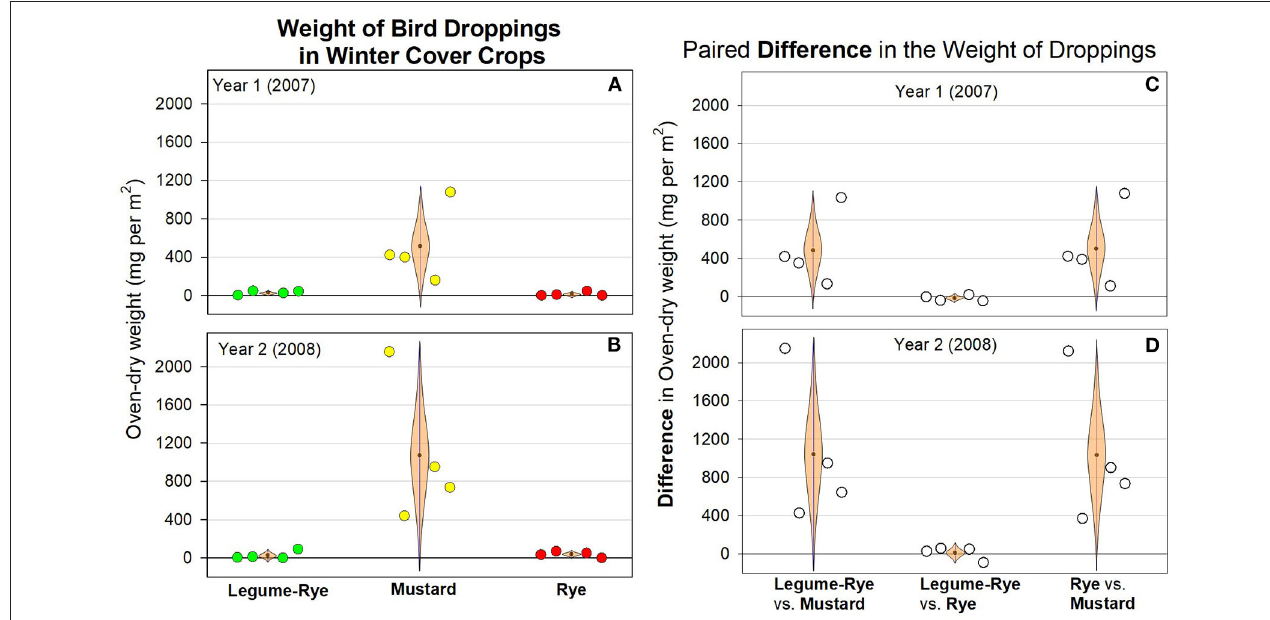
FIGURE 5 | The weight (A,B) of bird droppings under three winter cover crops, and their paired differences (C,D) , averaged across two seeding rates during two winters in Salinas, California. The data were collected in Feb 24 (Year 1) and Feb 13 to 15 (Year 2) that was ∼ 16–17 weeks after planting. The light brown, cat’s eye shaped error bars are 95% confidence intervals (CIs) with the sample mean at the central point on the bar. The CIs are shown in this shape to help illustrate how plausibility varies along the CI with values at the fattest (i.e., widest horizontal) area near the mean being several times more plausible to be the population mean ( µ ) than values at the ends of the CI. Data points are clustered around the mean in order of replicates 1–4. The mean weight of droppings in mg per m 2 was 29 [ − 3, 62] and 27 [ − 41, 94] in legume-rye, 514 [ − 114, 1,141] and 1,071 [ − 127, 2,268] in mustard, 13 [ − 21, 48] and 38 [ − 8, 83] in rye for Year 1 and Year 2, respectively. The mean difference in the weight of droppings in mg per m 2 for paired comparisons were 484 [ − 130, 1,099] and 1,044 [ − 178, 2,266] for legume-rye vs. mustard, − 16 [ − 65, 33] and 11 [ − 98, 120] for legume-rye vs. rye, and 500 [ − 151, 1,151] and 1,033 [ − 175, 2,241] for rye vs. mustard, in Year 1 and Year 2,